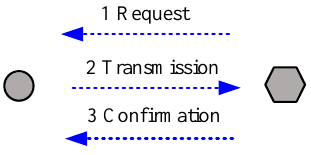
Figure 9. Passive node transmission mode.